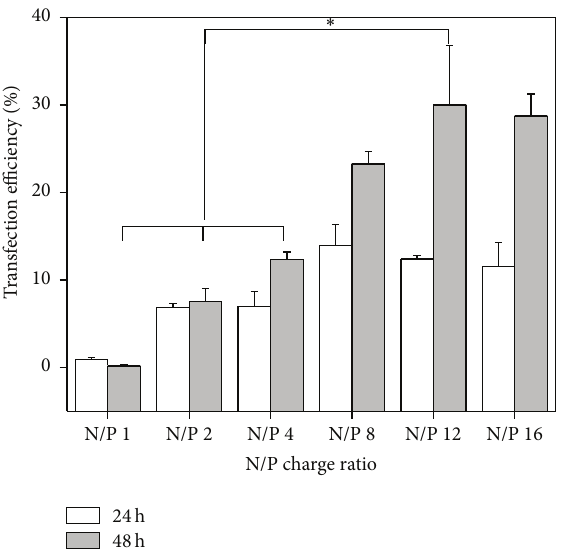
Figure 5: Transfection efficiency of hTMSCs treated with DNA-PEI NPs at N/P charge ratios of 1–16 ( ∗ 𝑃 < 0.001